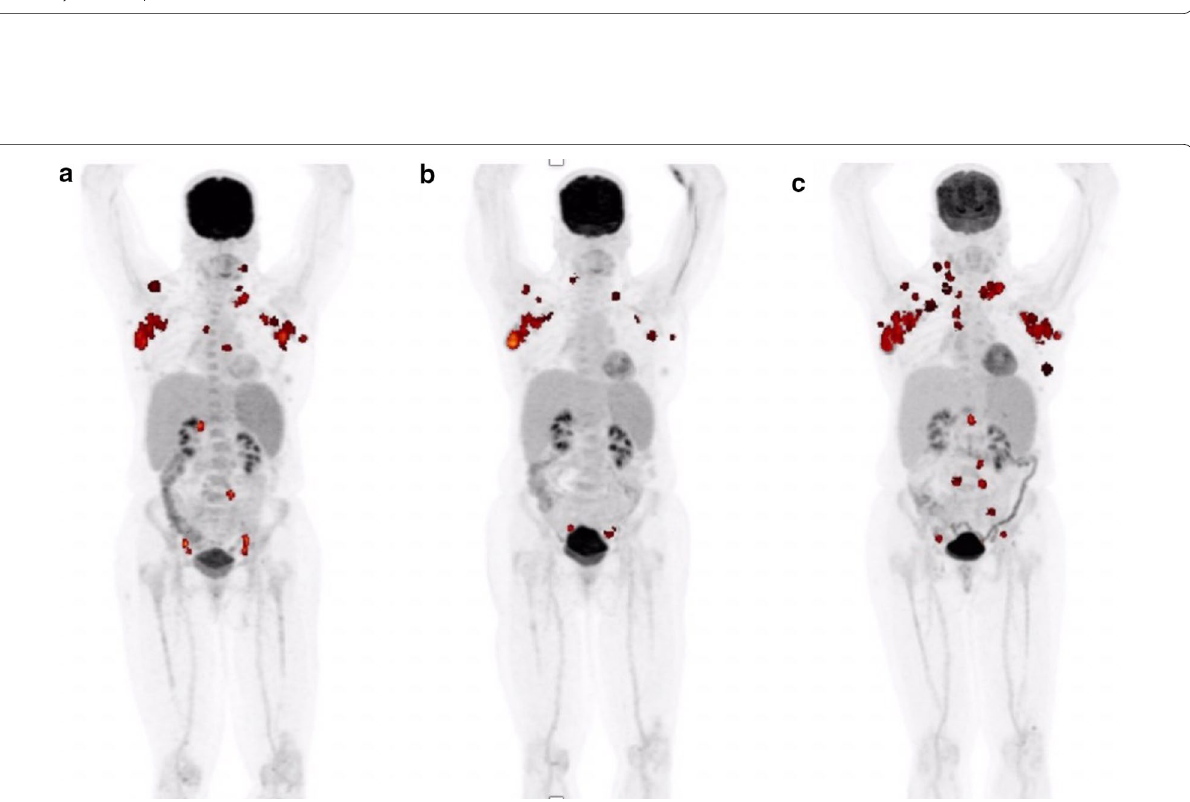
Fig. 5 A subject with multicentric Castleman disease (MCD) with lesions in the axillary, neck, and abdomen is shown over the course of 10 months. a indicated the initial lesions seen in PET before treatment. b was taken after 4 months from the initial scan, and a decrease of lesions in the axillary, neck, and abdomen is seen. However, the disease seemed to reappear in the axillary and cervical lesions despite treatment as visualized in c , which was taken 6 months after the scan for b . Total lesion glycolysis (TLG) was calculated to be 365.9, 204.5, and 601.6 for a–c , respectively. TLG was calculated by multiplying the metabolic volume with FDG uptake segmented by fixed threshold methods at 41% of maximum SUV in the volume of interest (VOI) [75] by the mean standardized uptake value (SUVmean) and then summing all the intensity‑volume product values from all